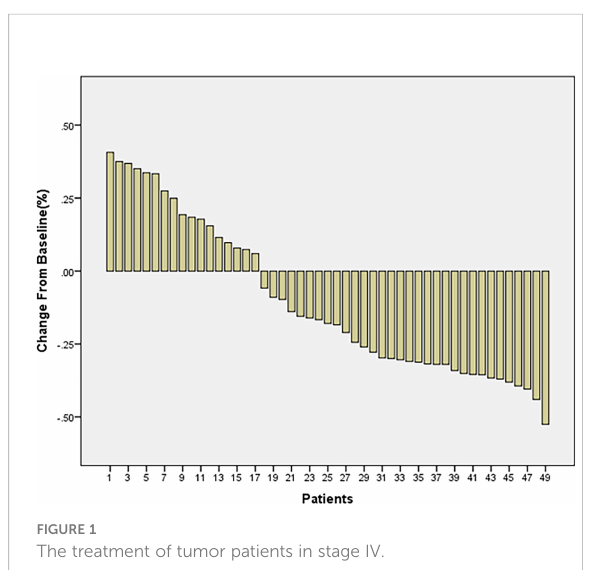
FIGURE 1 The treatment of tumor patients in stage IV.